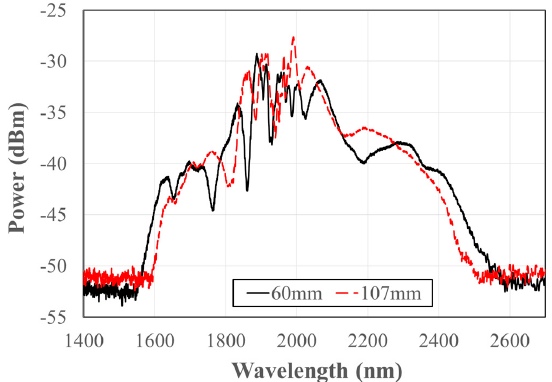
Figure 8. Supercontinuum at fiber lengths of 60 mm and 107 mm.